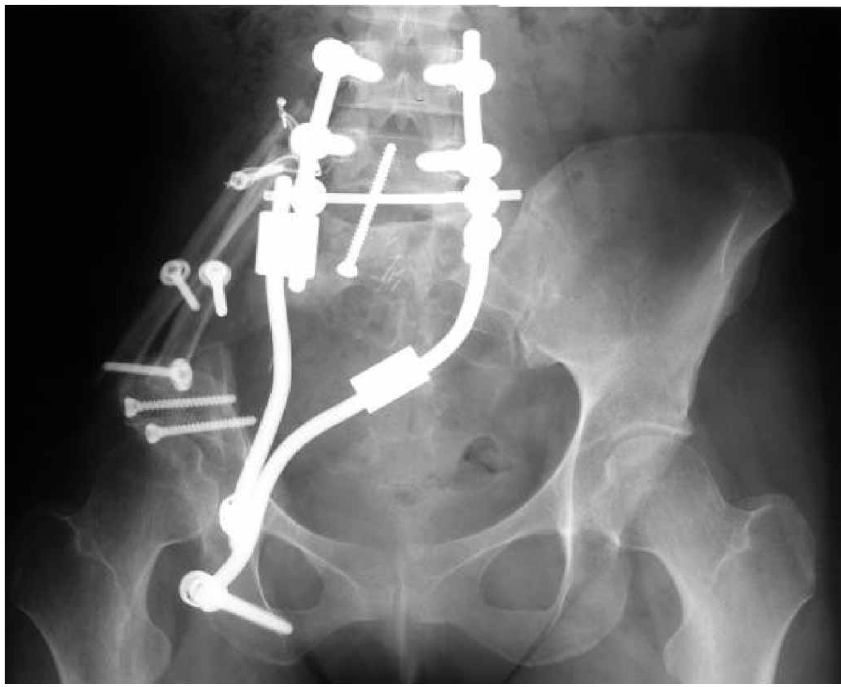
Fig. 5. X-ray after the second operation. Stabilisation of the pelvic ring: two ischial screws in place, transpedicular spondylodesis and autologous bone graft; the screw visible in the midline of L5 was left after the first